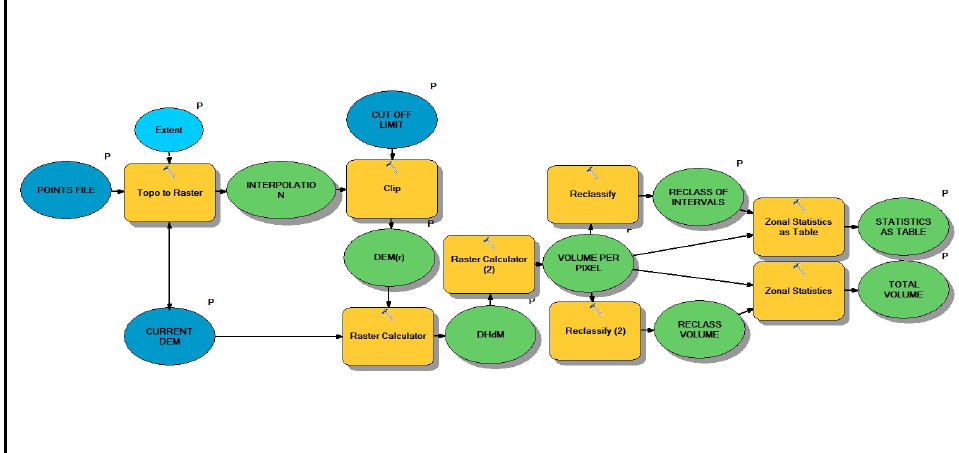
Figure 7. Volume calculation workflow diagram in ArcMap 10.7. The reader can find the tool in the Supplementary Materials (Volumetric_Tool.zip).